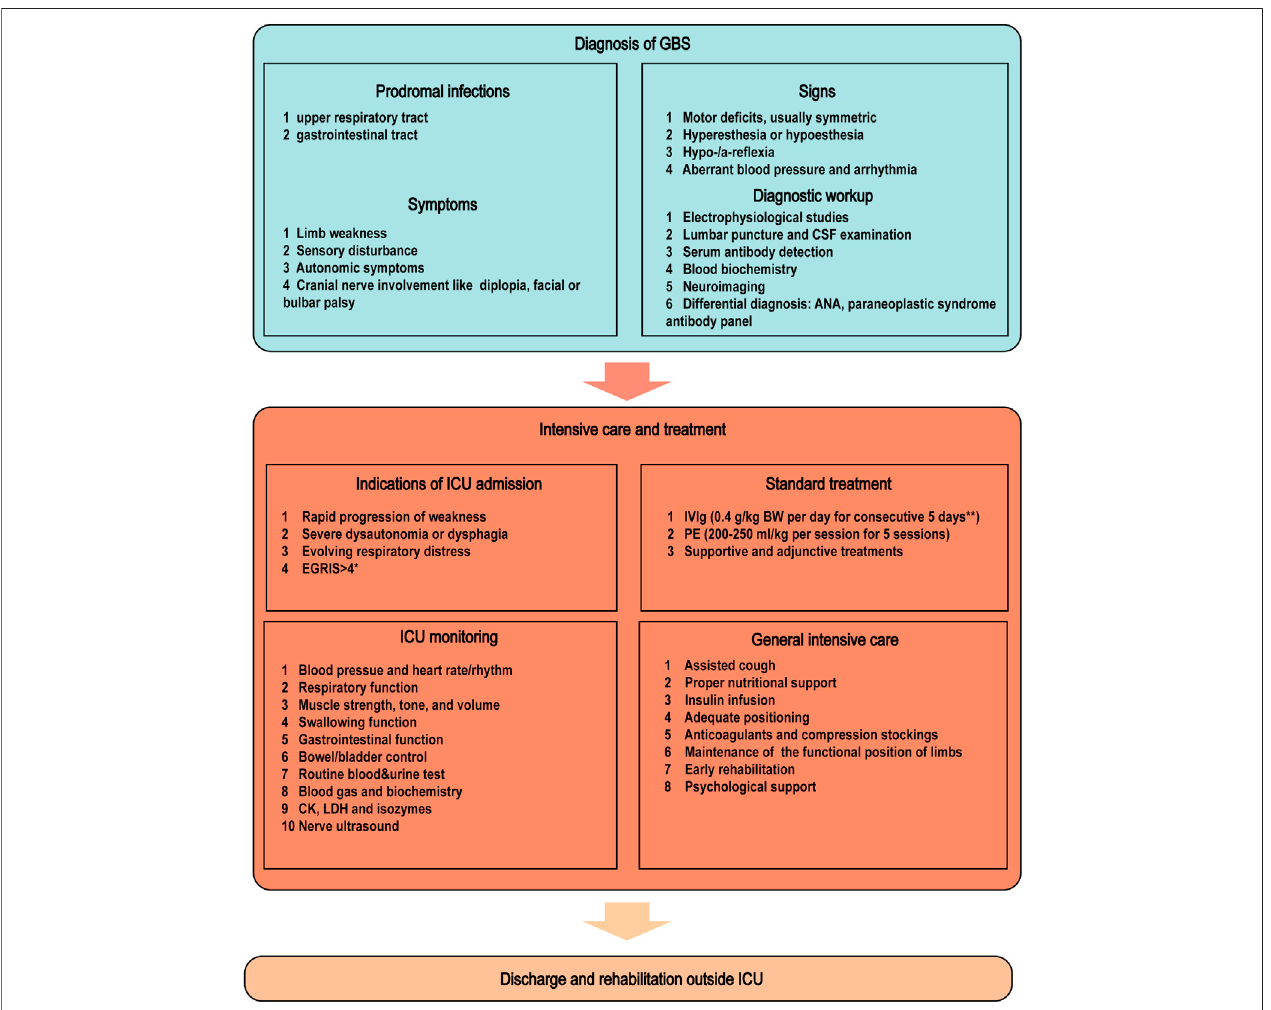
FIGURE 2 | ICU admission and management of severe GBS. The diagnosis of GBS is based on the prodromal infections, symptoms, and signs combined with laboratoryworkupsincludingelectrophysiologicalstudiesandCSF/serumtests.PharmacologicaltreatmentsshouldbeappliedimmediatelyinprogressiveGBSpatients who cannot walk without aid. Decision-making as to ICU admission should be based on EGRIS, respiratory function, and extent of dysautonomia/dysphagia. The ICU monitoring of physiological parameters facilitates the recognition of GBS progression and the decision-making process for neurointensivists. *EGRIS is calculated via integrating MRC scores, facial/bulbar weakness, and duration from the onset to admission. **IVIg at 2g/kg BW can even be completed within 2 or 1 day in heathy cohorts, especially for young patients with normal cardiac and renal functions. Abbreviations: ANA, antinuclear antibody; BW, body weight; CK, creatine kinase; CSF, cerebrospinal fl uid; EGRIS, Erasmus GBS respiratory insuf fi ciency score; GBS, Guillain – Barré syndrome; ICU, intensive care unit; IVIg, intravenous immunoglobulin; LDH, lactate dehydrogenase; MRC, Medical Research Council; PE, plasma